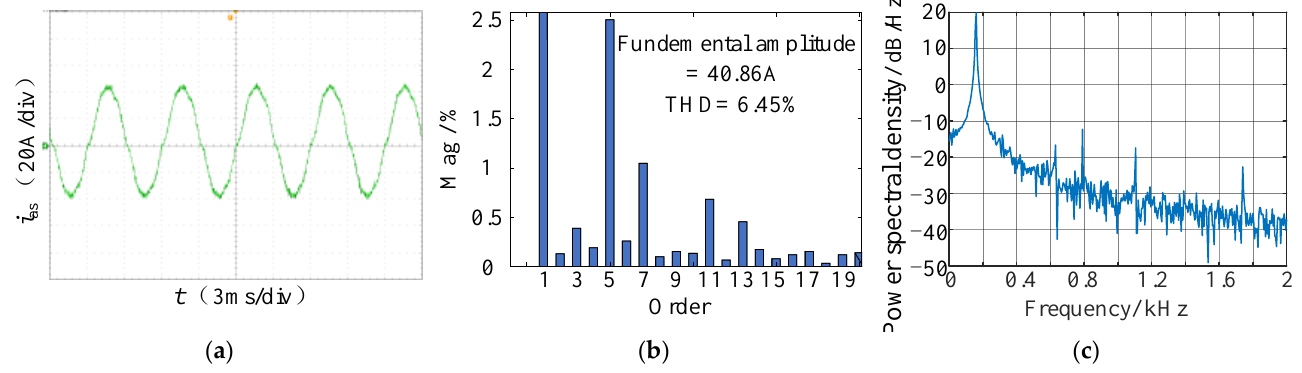
Figure 24. Experimental results under pulse time compensation. ( a ) i as ; ( b ) FFT; ( c ) Power spectral density.